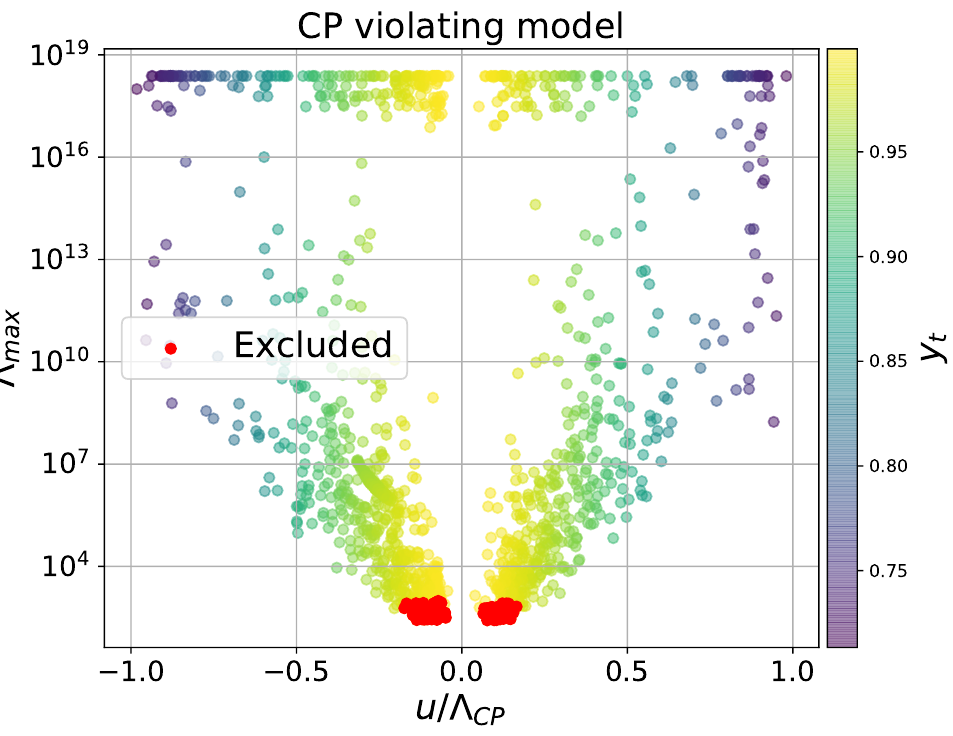
Figure 13 . Maximum renormalization scale where positivity and perturbativity are satified as a function of u/ Λ CP . The coloured side-bar shows the value of the top Yukawa coupling.